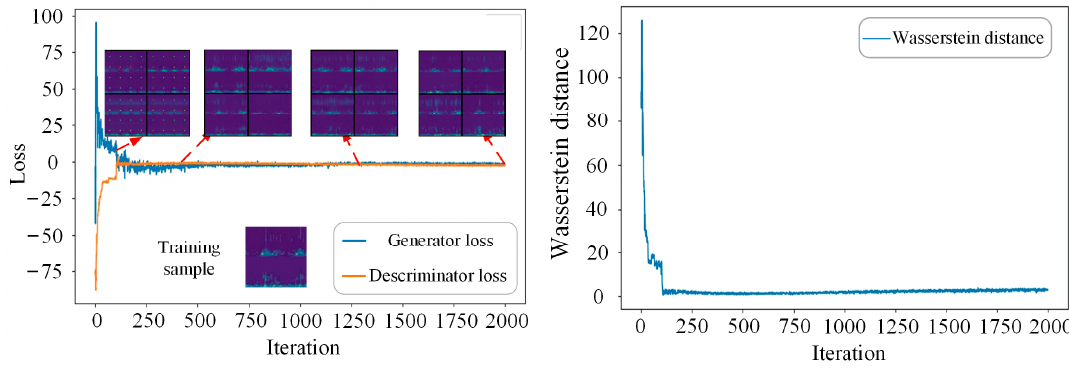
Figure 9. The training process of IDCGAN with 100 IRF samples.